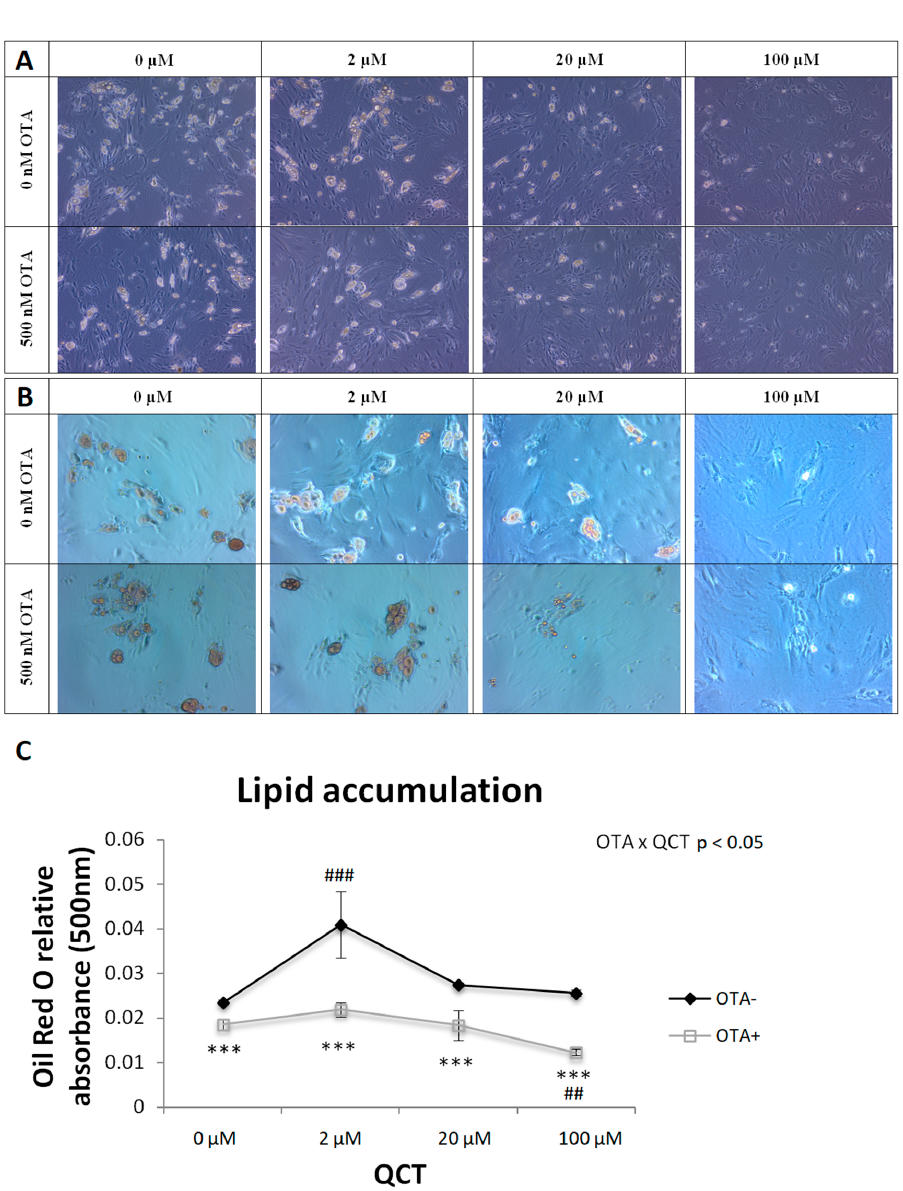
Figure 2. Histochemical staining of lipid accumulation by Oil Red O in differentiating primary rat preadipocytes cultured in medium with (OTA+) or without ochratoxin A (OTA-) and quercetin (QCT) at various concentrations. Cells were scanned both naive ( A ) and after histochemical staining with Oil Red O ( B ), magnification 100 ×. The absorbance of the Oil Red O eluate was measured at 500 nm ( C ). The results, presented as mean ± mean error (SEM), were analyzed by two-way ANOVA with factors QCT and OTA, followed by Bonferroni post-hoc test. The level of statistical significance considered for factor OTA was *** p < 0.001, and for factor QCT ## p < 0.01; ### p < 0.001. The expression of the molecular markers of adipogenesis was in accordance with the results of Oil Red O staining (Figure 3). A significant interaction of the two main factors was detected on the mRNA levels of aP2 ( p < 0.05), Fas ( p < 0.01), and Ppar γ ( p < 0.01). The expression of all three markers